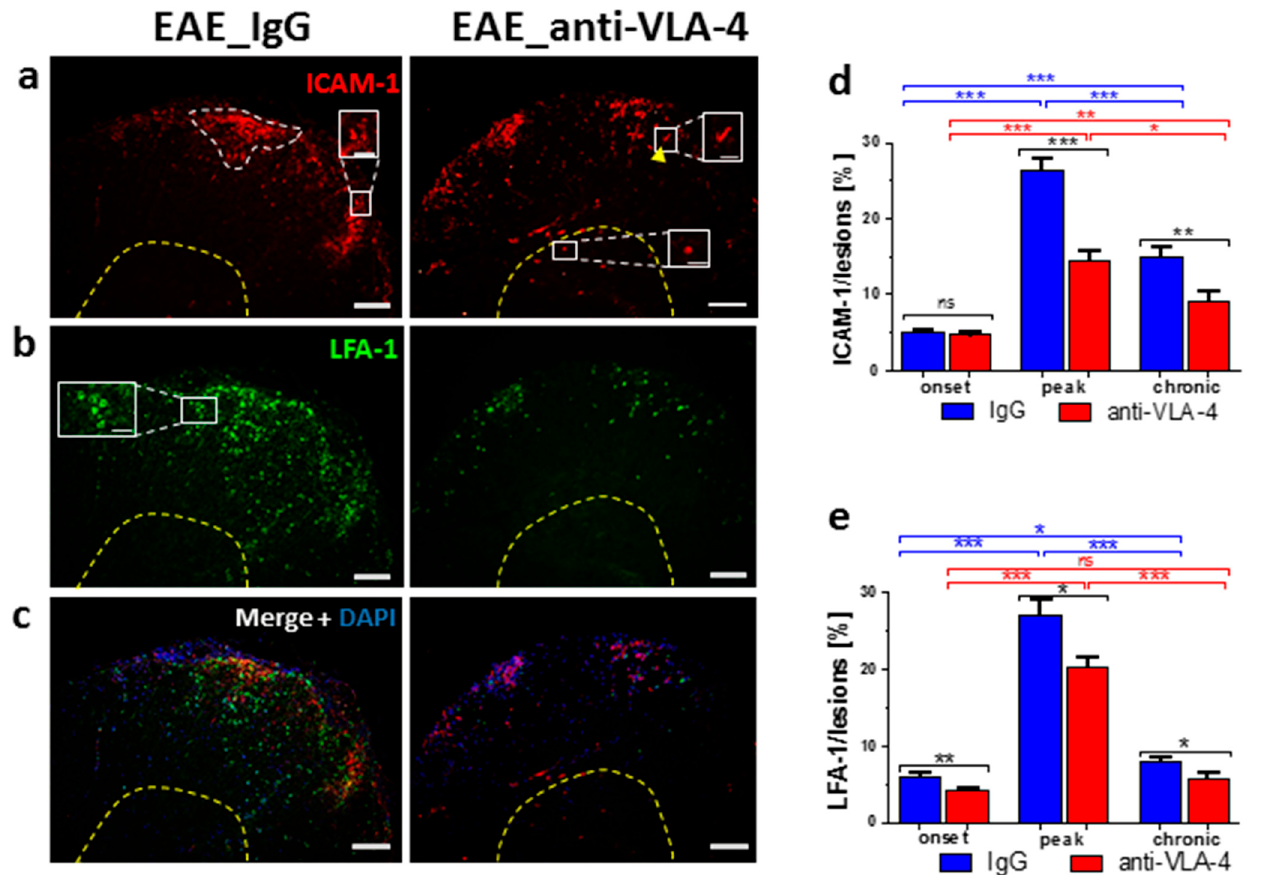
Figure 3. Immunostaining of ICAM-1 ( a ), LFA-1 ( b ) and their overlapping fluorescence with DAPI nuclear staining ( c ) in cross-sectioned spinal cords of IgG- and anti-VLA-4-treated mice in the peak phase of EAE, as well as their quantitative measurements. ICAM-1 and LFA-1 expression was quantified as percentage of lesion area occupied by immunopositive structures ( d , e ); white dotted line marks an exemplary lesion in which expression of adhesion molecules was measured. Localization of LFA-1 is associated with inflammatory cells ( b,c ), and localization of ICAM-1 is associated with inflammatory cells ( a , inset), a few nerve cells in gray matter ( a , inset) and capillaries ( a , inset, arrowhead). Data are presented as means ± SEM; n = 5 per group. Statistical significance was verified using a two-sided Mann–Whitney test at 0.05 confidence level (*** p < 0.001; ** p < 0.01; * p < 0.05; ns—not significant). Magnification is indicated by scale bars (( a – c ) = 100 µm; insets = 25 µm).